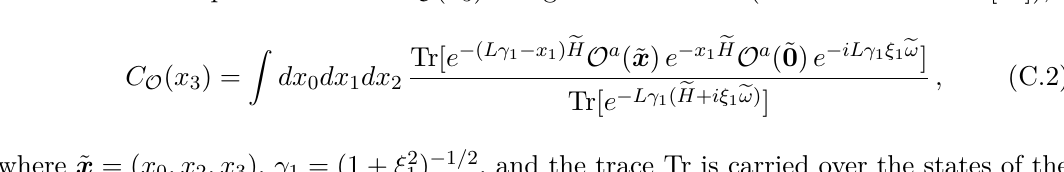
( x ) along the 1 -direction (cf. section 4 of ref. 3 O